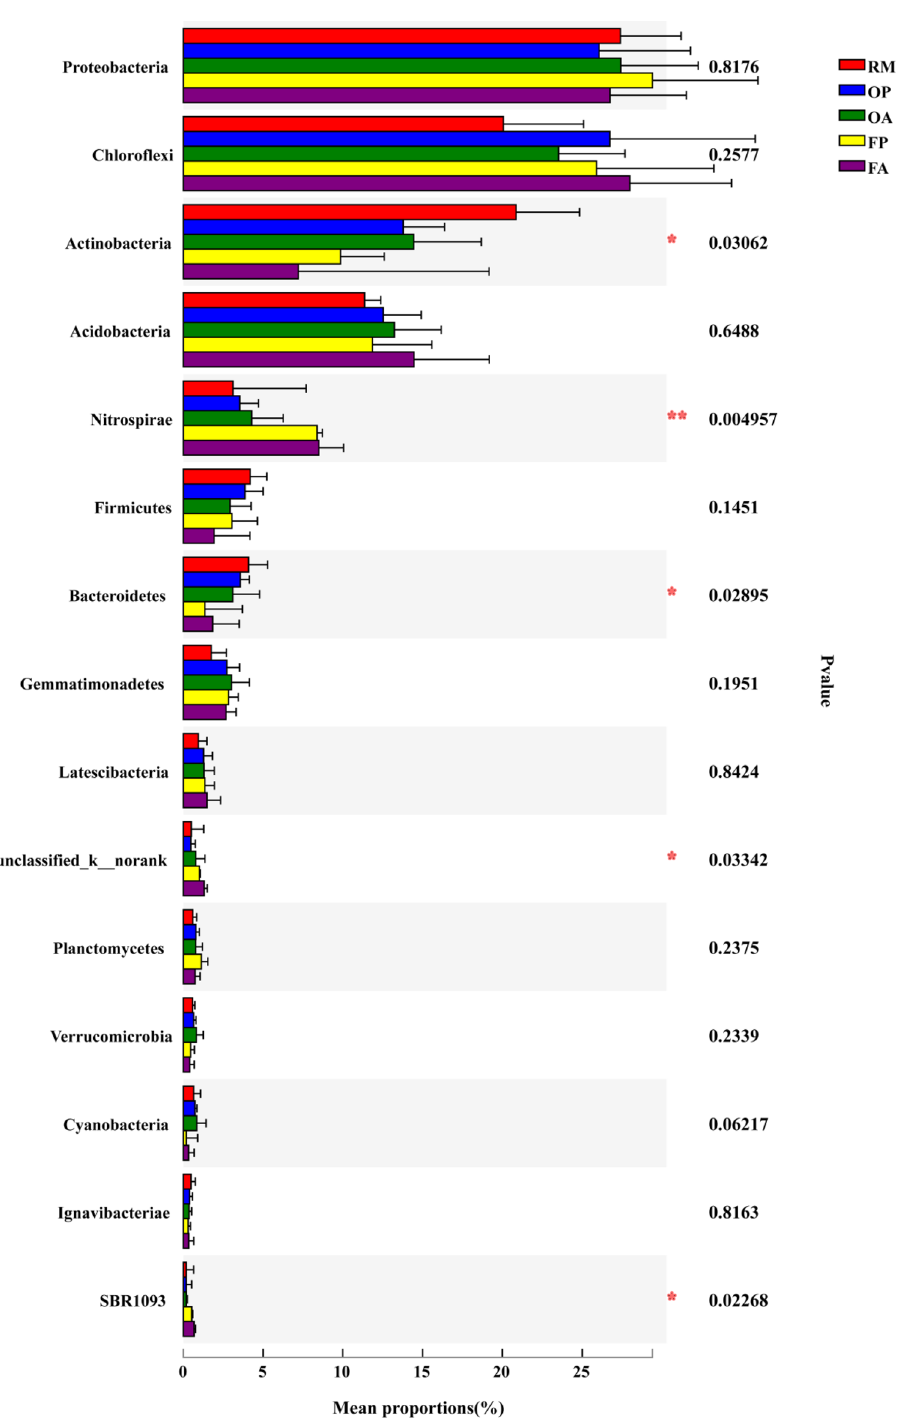
Figure 3. The differences with significance of the top 15 phyla in different rice systems and areas (* indicates 0.01 < P ≤ 0.05, ** indicates 0.001 < P ≤